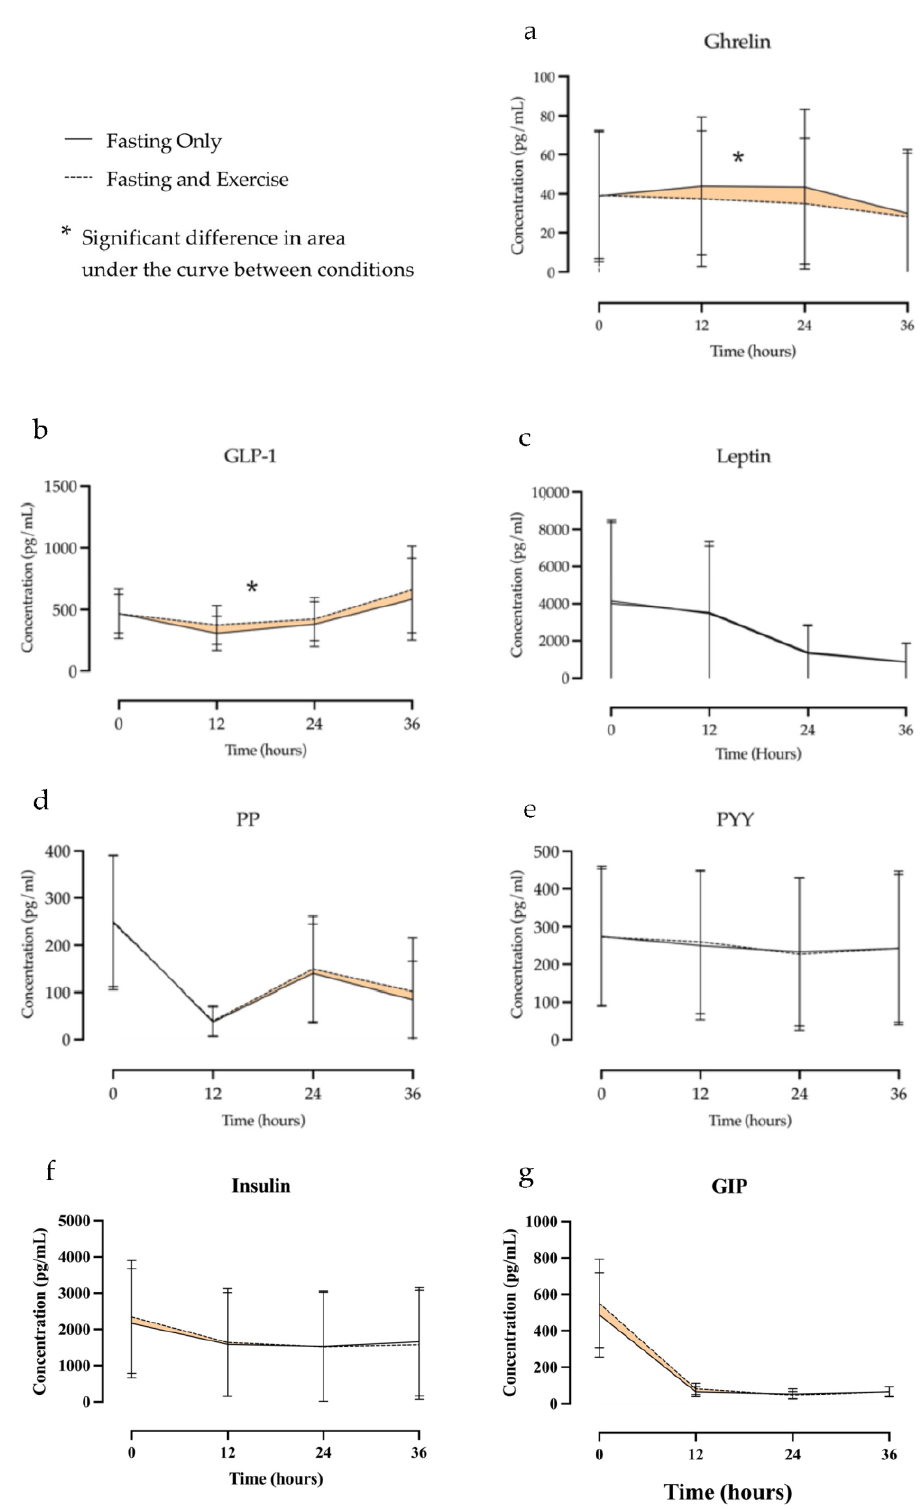
Figure 2. Concentrations of ghrelin ( a ), GLP-1 ( b ), leptin ( c ), PP ( d ), PYY ( e ), insulin ( f ), and GIP ( g ) over the course of a 36 h fast. Differences in area under the curve are highlighted.